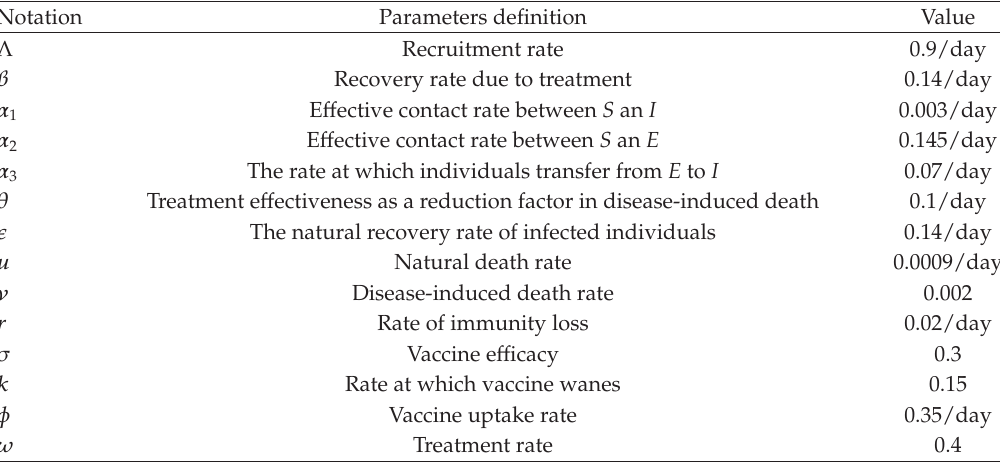
Table 1: Parameter values used for numerical